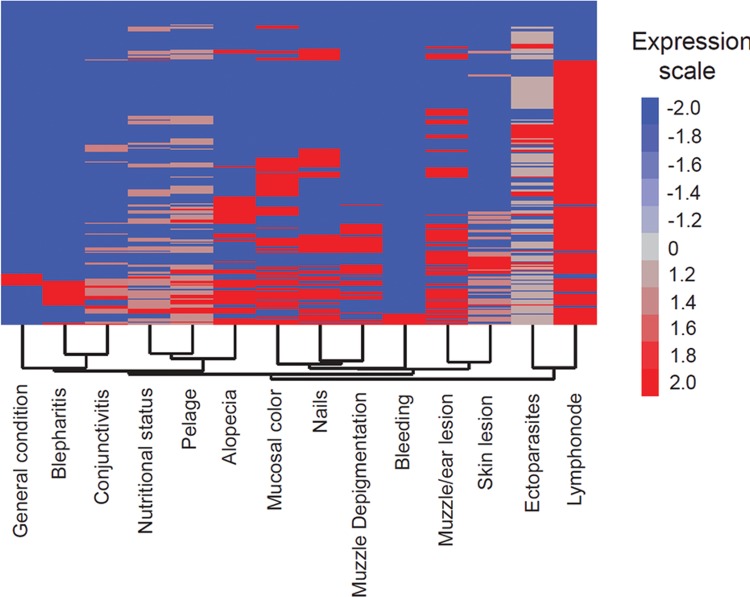
: heat map analysis of all sick dogs. Fourteen different signs were evaluated according to the proposed clinical score, and a two-way hierarchical cluster analysis (Ward’s method) was performed to identify patterns of associations between different signs among all the dogs. The colours show the fold variation from the median values (log transformed) calculated for each sign as represented by the expression scale.